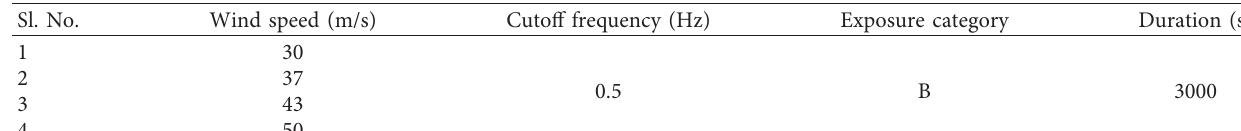
Table 4: Details of the wind time history.